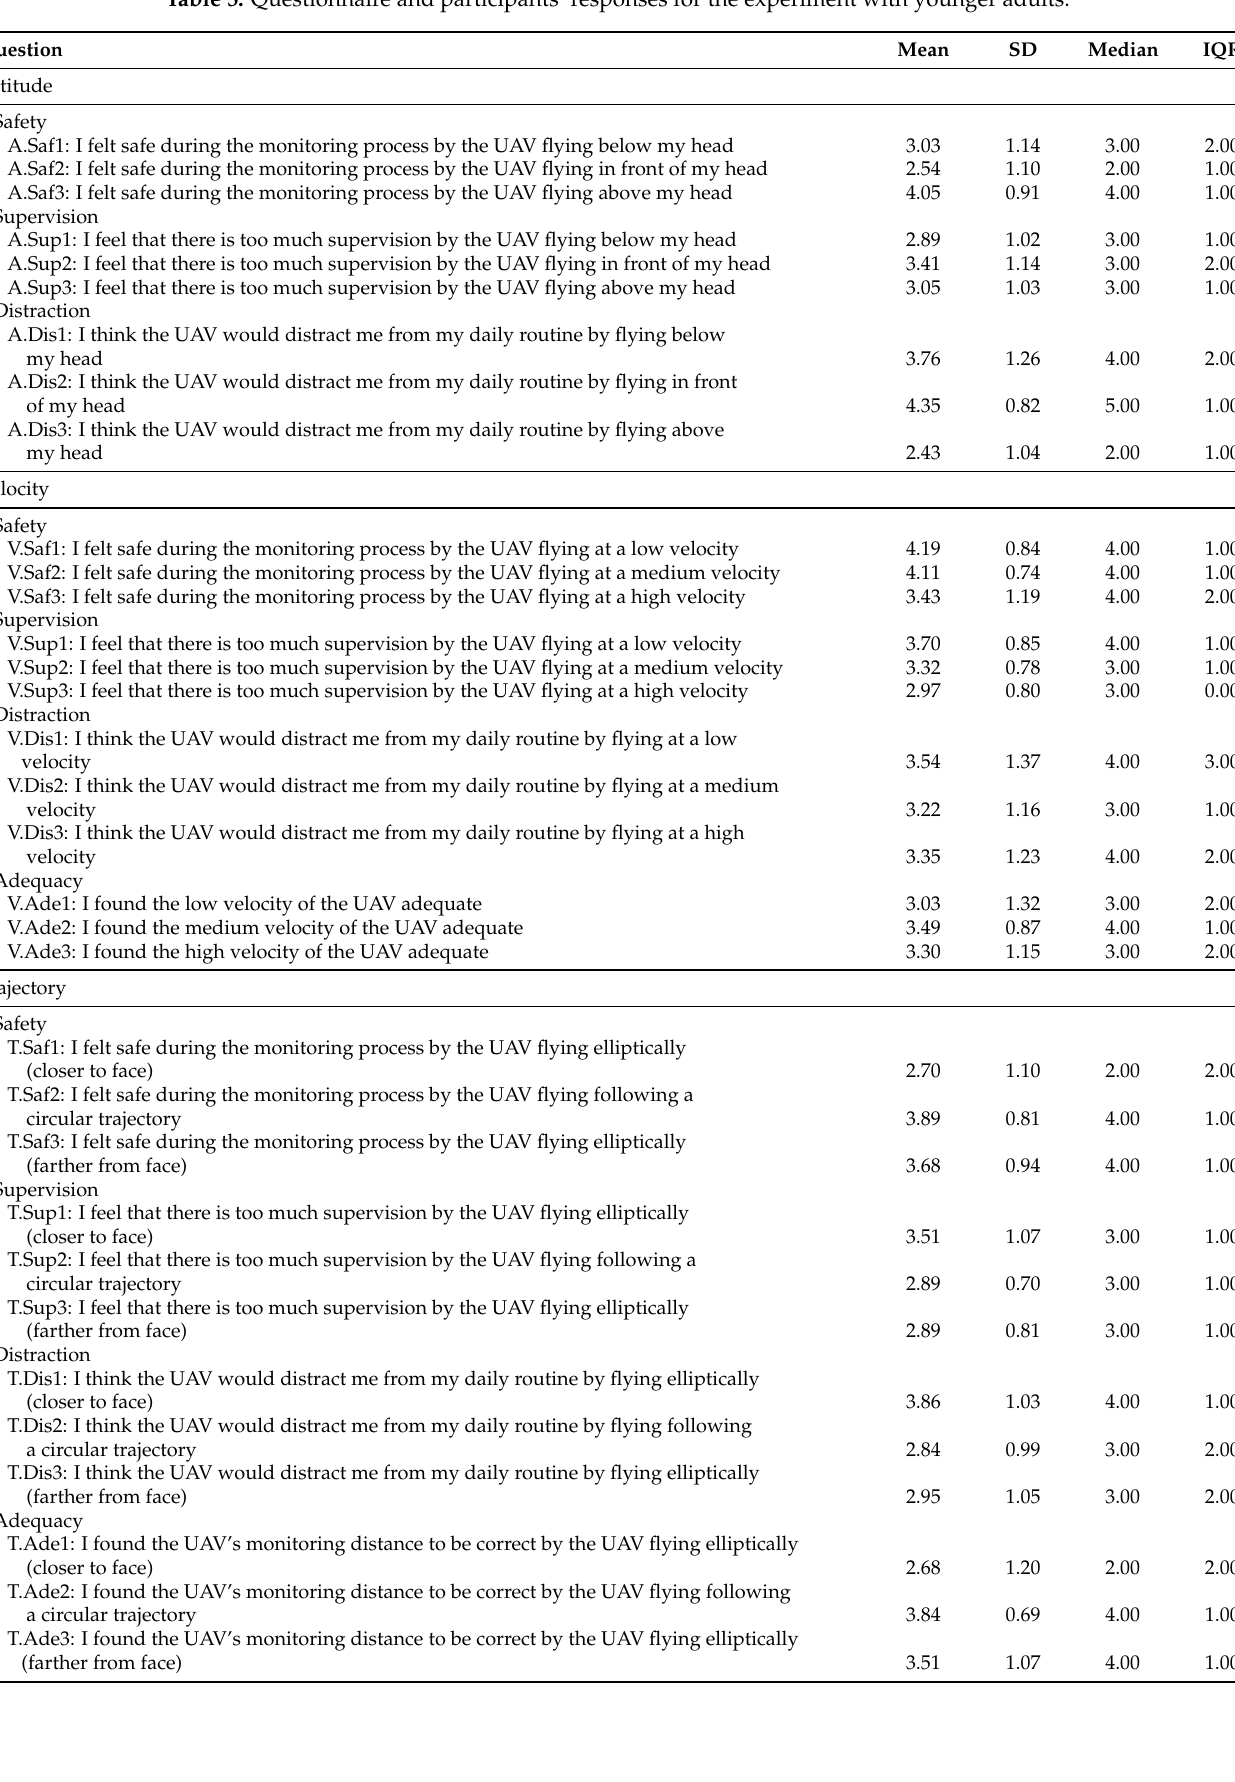
Table 5. Questionnaire and participants’ responses for the experiment with younger